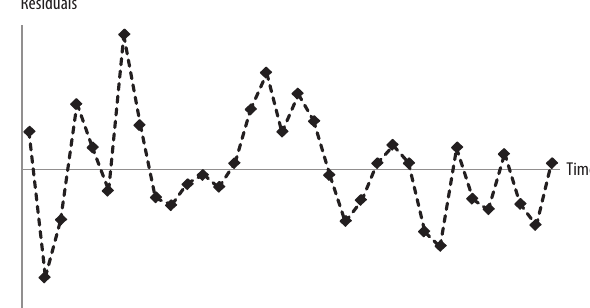
Fig. 6. Residuals of the estimated equation (3a) show positive serial